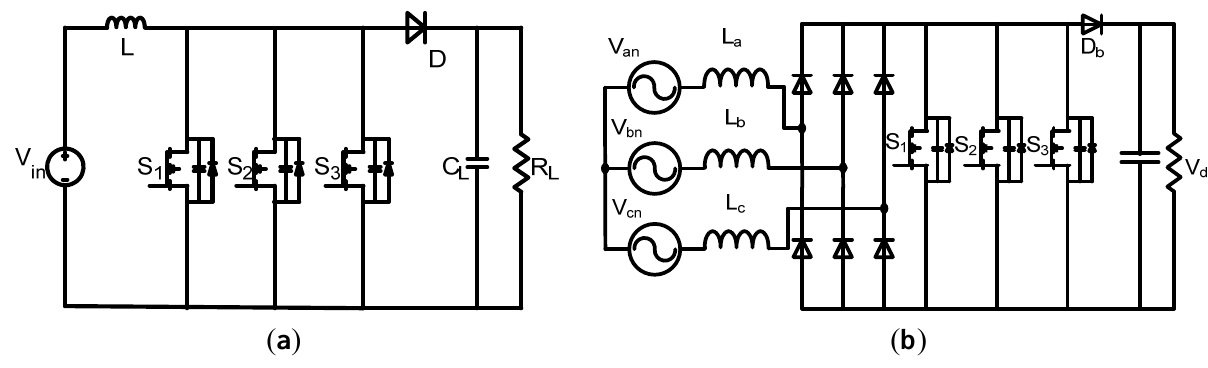
Figure 2. Converters with paralleled MOSFETs. ( a ) DC-DC boost converter; ( b ) Three-phase boost rectifier.